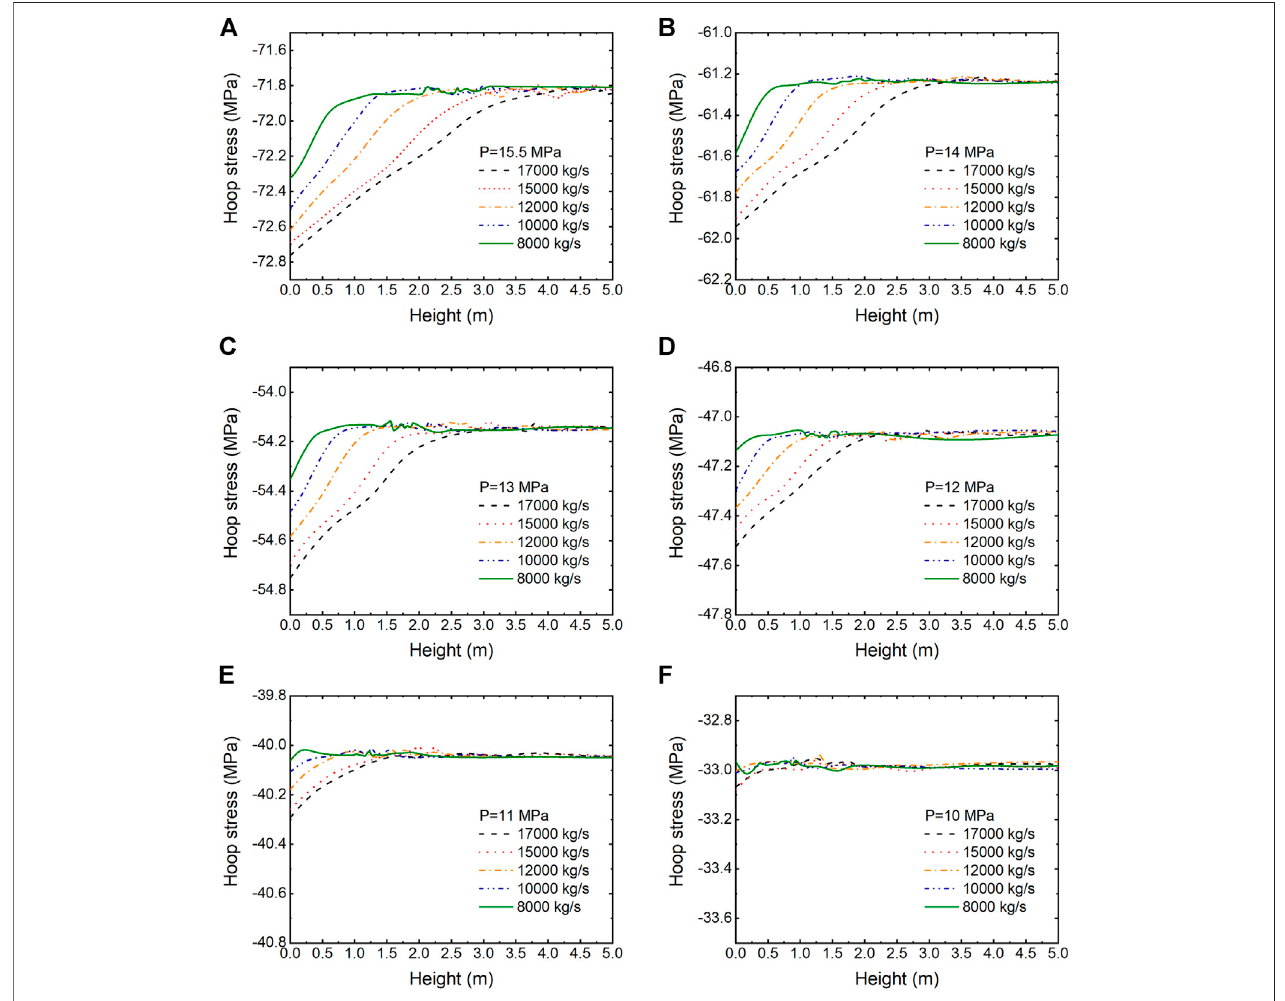
FIGURE 13 | Averaged hoop stress of UO 2 fuel under different coolant pressures and mass fl uxes.